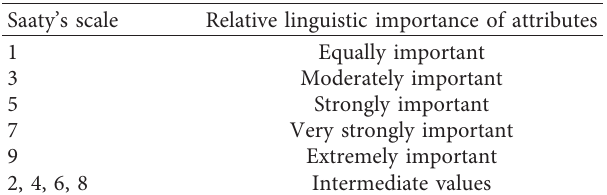
Figure 2: A hierarchy structuration of the network selection problem. Table 1: Saaty’s scale for the important judgments in the pairwise